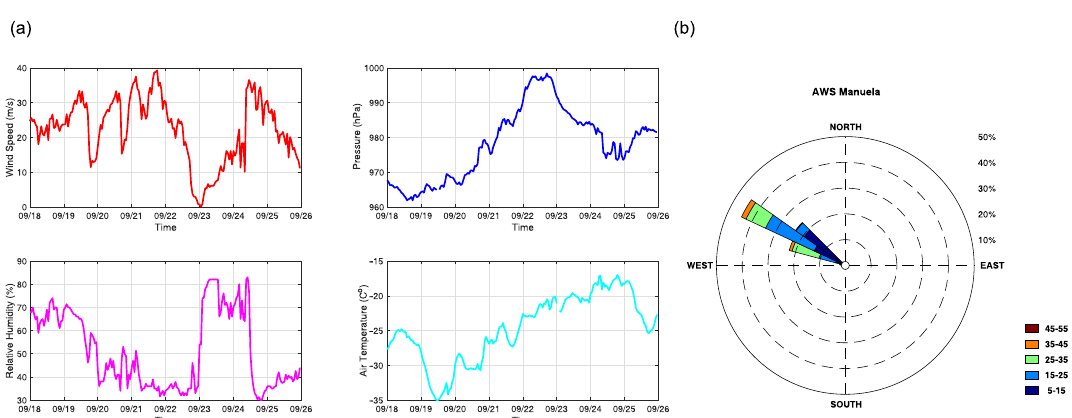
Figure 4. Measurements from Manuela AWS for the period of 18–25 September 2012 (http://amrc.ssec. wisc.edu).